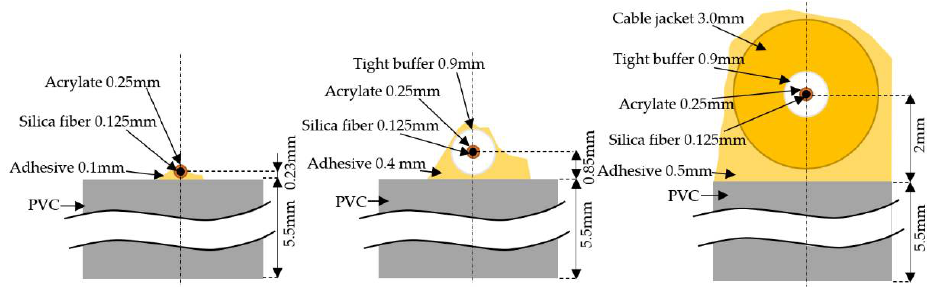
Figure 2. Schematic cross-section of three types of single-mode optical fiber.